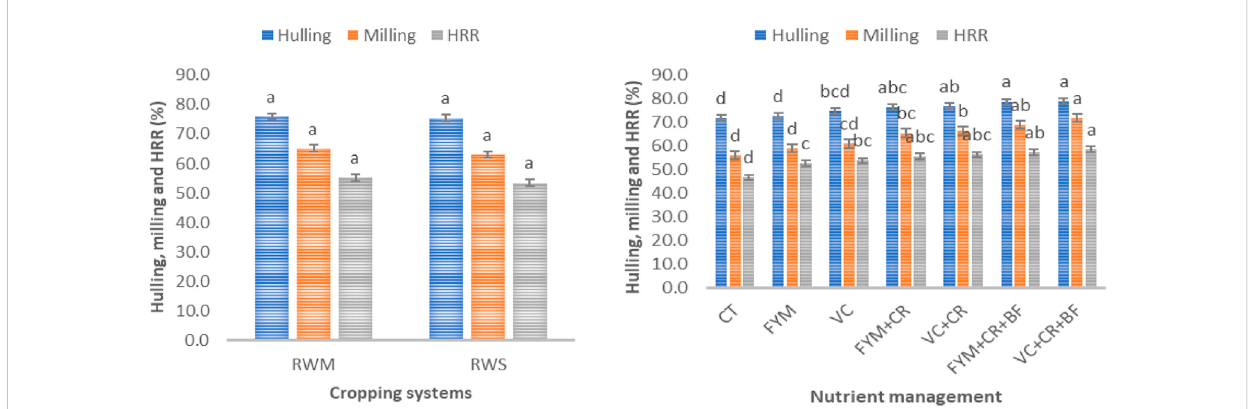
FIGURE 11 Long-term effect of cropping systems and organic nutrient management on hulling, milling, and HRR. HRR: head rice recovery; RWM: rice-wheat- mung bean; RWS: rice-wheat-sesbania; CT: control; FYM: farm yard manure; VC: vermicompost; CR: crop residue(s); and BF: biofertilizer(s). Statistical method: analysis of variance for strip-plot design in SAS 9.3 software; n = 42. Values with a different capital letter indicate a signi fi cant difference among the different treatments at p < 0.05 by the LSD test. Bars represent means ± SEM.